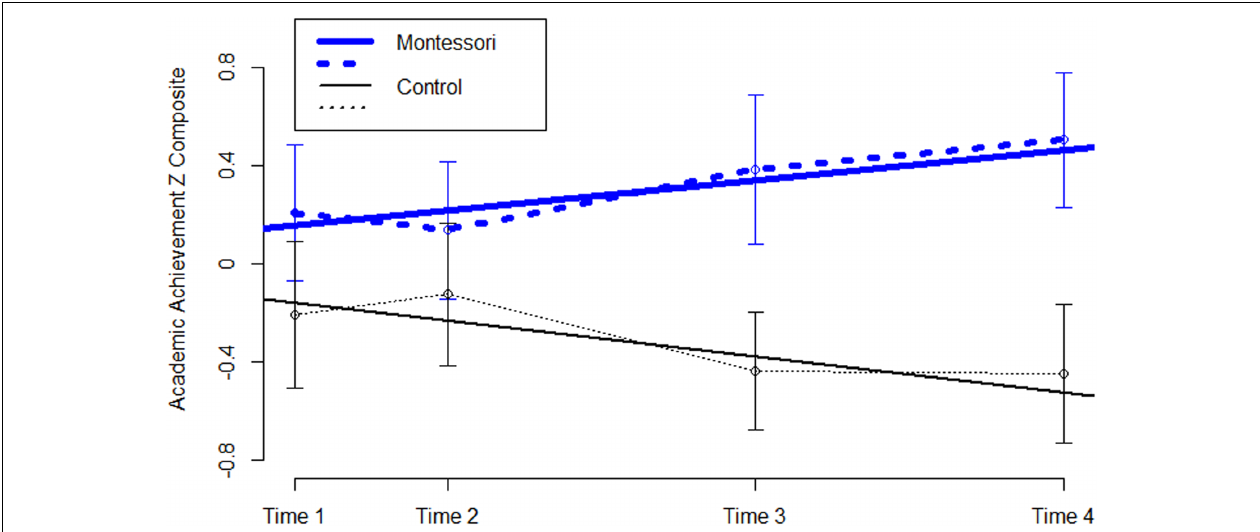
FIGURE 2 | Academic achievement across preschool by school type. The figure shows significantly greater growth in academic achievement across preschool for children enrolled in Montessori preschool (dashed blue lines, n = 70) than waitlisted controls (dotted black lines, n = 71). Groups were statistically equivalent at Time 1 (the non-significant difference at Time 1 is likely due the Time 1 tests occurring into mid-December, thus school programs could already have made a difference) and Time 2 (late in the spring of their 1st year in preschool) and significantly different by the end of their 2nd and 3rd years in preschool (Times 3 and 4). Dashed/dotted lines represent actual data and solid lines represent fitted linear growth curves. Standard error bars are